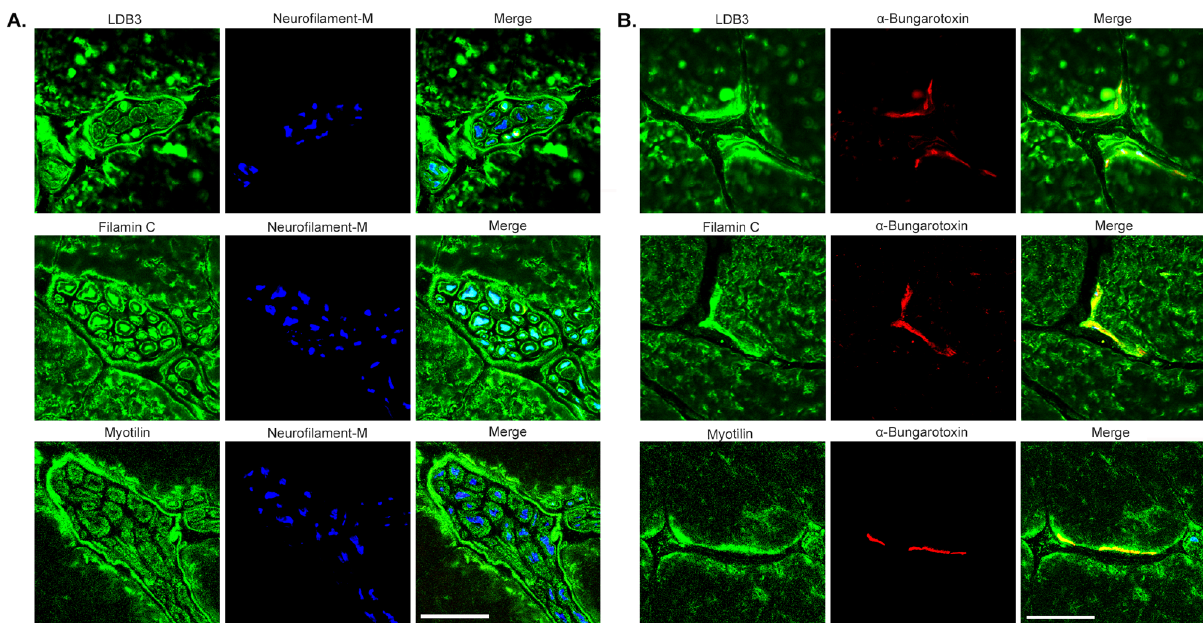
Figure 5. Immunolocalization of LDB3, filamin C, and myotilin in peripheral nerve and NMJ. ( A , B ) Representative immunofluorescence on tibialis anterior muscle cross-sections from six-month old mice (n = 6) show LDB3, filamin C, and myotilin staining (green) localized to intramuscular nerve fibers ( A ) and NMJs ( B ) marked by expression of neurofilament-M (blue) and α-Bungarotoxin (red), respectively. Scale bar (25